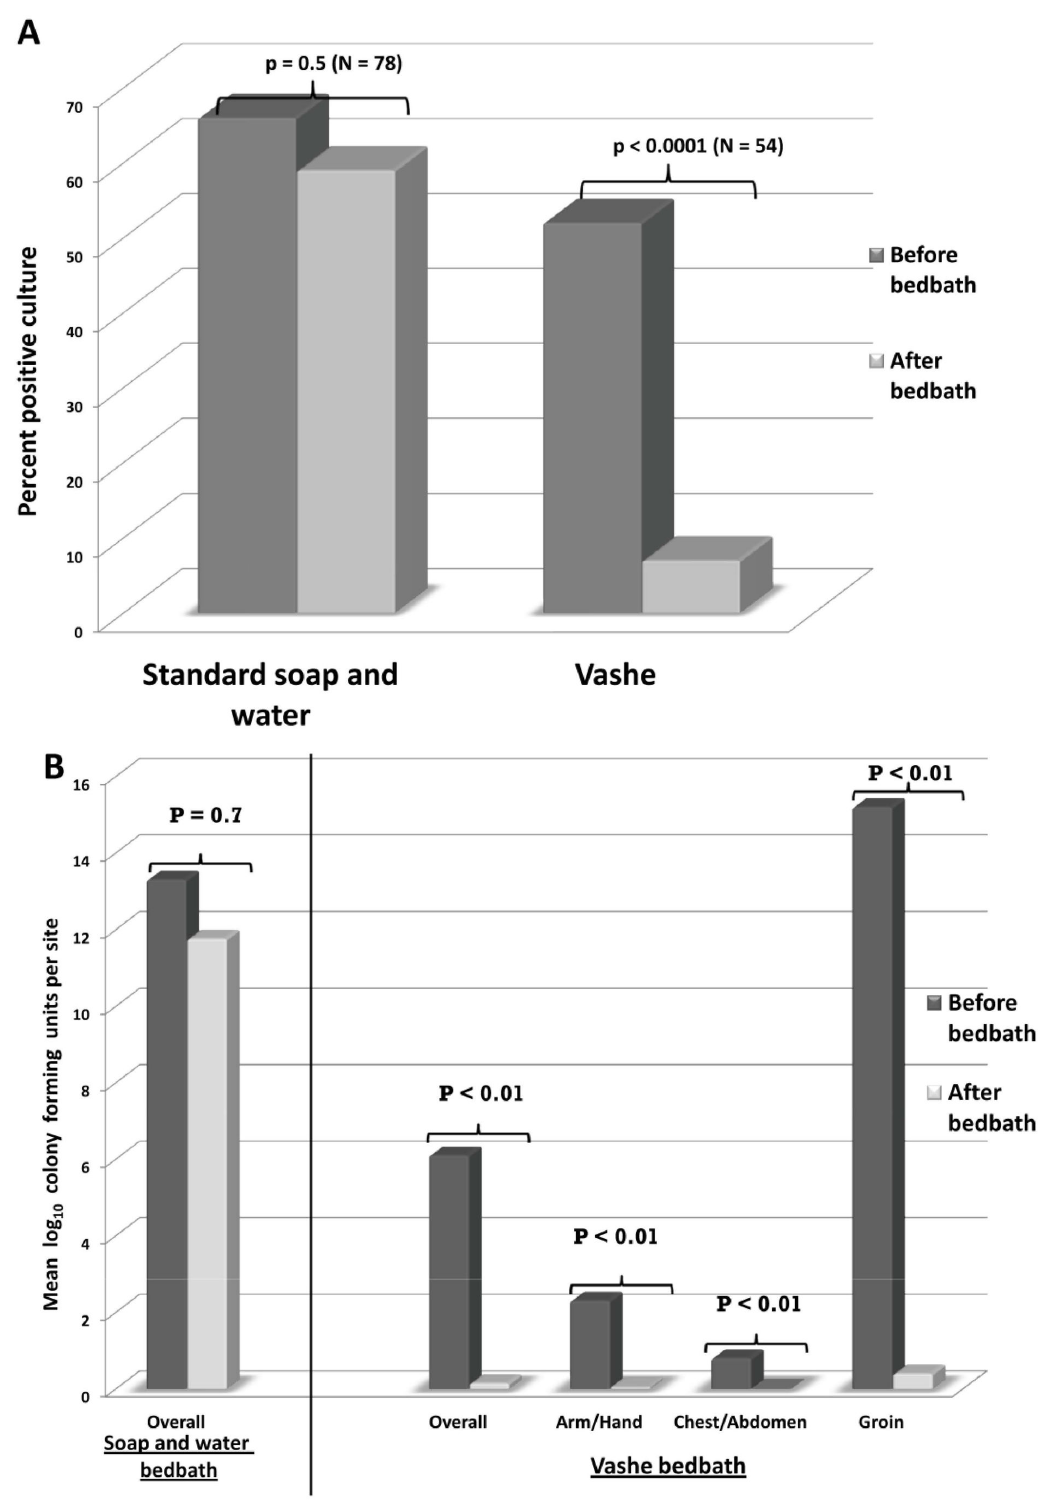
Figure 4. Effectiveness of bed baths using Vashe for removal of spores from skin. Comparison of soap and water versus Vashe bed baths for removal of Clostridium difficile spores from skin of patients with Clostridium difficile infection. (A) Percentage of positive skin cultures. (B) Mean colony-forming units of C. difficile recovered.